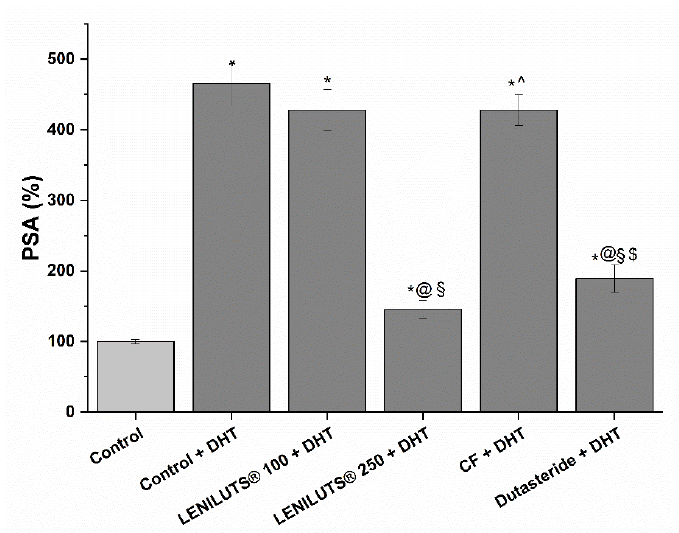
Figure 5. Prostate-specific antigen release in LNCaP prostatic cells following stimulation with DHT and treatment with LENILUTS ® , CF and Dutasteride. * p < 0.05 vs. Control, @ p < 0.05 vs. Control + DHT, § p < 0.05 LENILUTS 100 + DHT, ^ p < 0.05 vs. LENILUTS 250 + DHT, $ p < 0.05 vs. CF + DHT. 5. + DHT, § p < 0.05 LENILUTS 100 + DHT, ˆ p < 0.05 vs. LENILUTS 250 + DHT, $ p < 0.05 vs. CF + DHT.